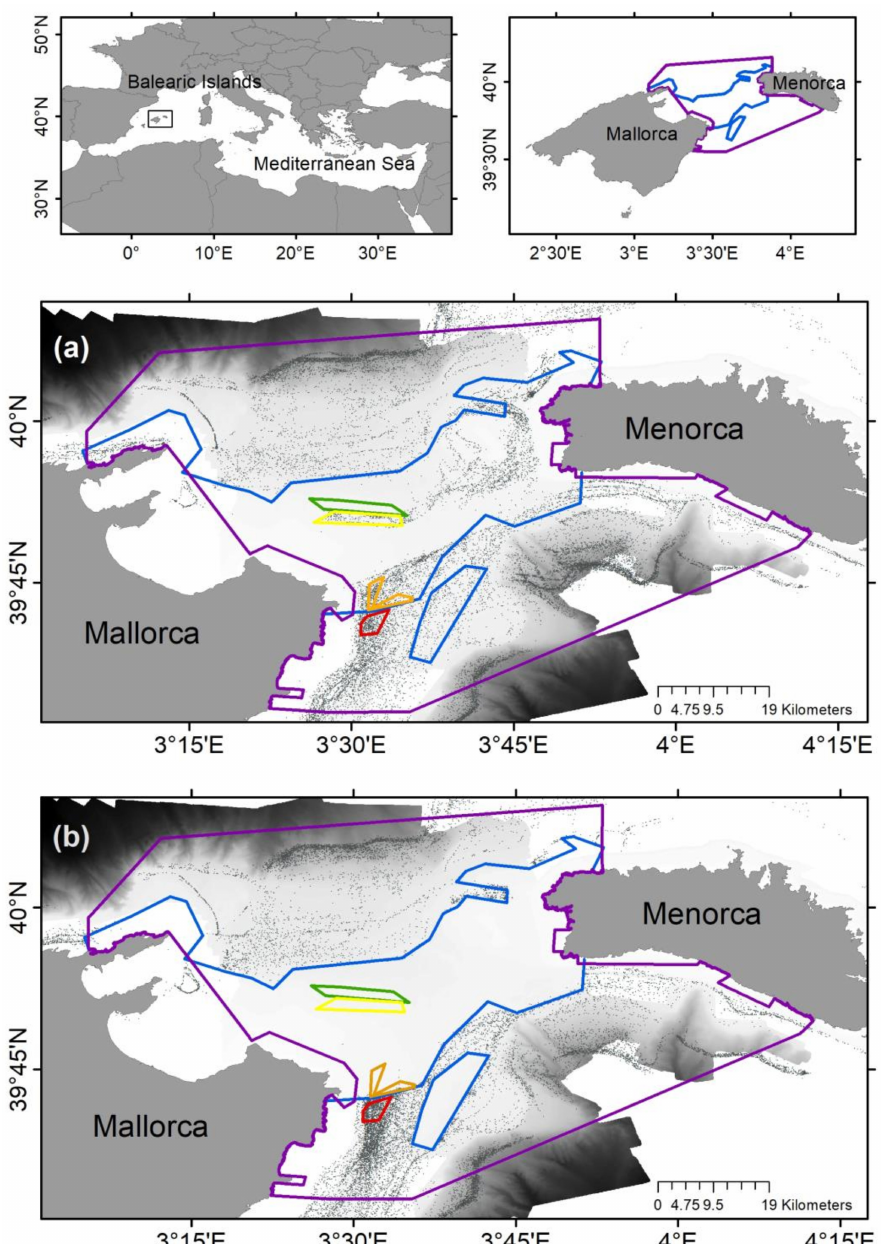
Figure 1. Map of the Menorca Channel (Balearic Islands, western Mediterranean) showing the Site of Community Importance (SCI; in lilac) and the trawl Fishing Protected Zones (in blue), declared in 2014 and 2016, respectively. The signals from the Vessel Monitoring System (VMS) during the periods: ( a ) 2014–2015 and ( b ) 2017–2018 are represented. The four areas with different levels of bottom trawl fishing effort (Non-Impacted: green; Low effort history: yellow; Medium effort history: orange; High effort: red) compared in the present study are also